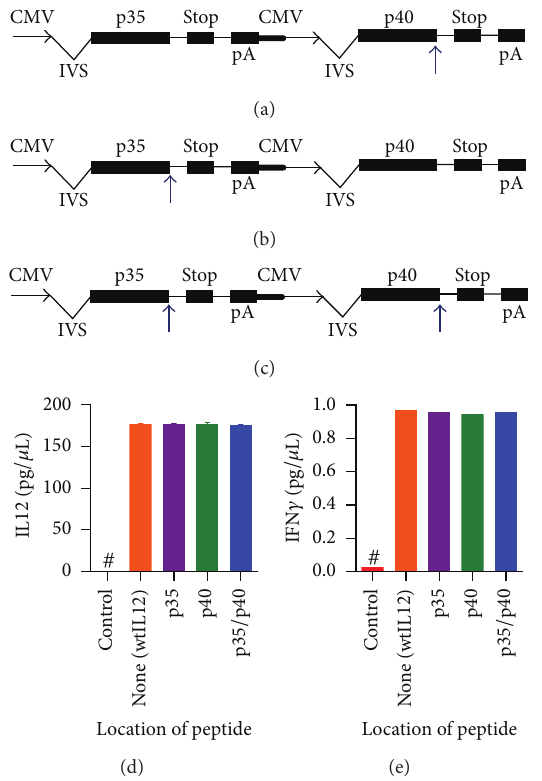
Figure 1: Expression and activity of IL12 is not affected by insertion of tumor-targeting sequence in either subunit. Multiple VNTANST- IL12 plasmids were created with the VNTANST sequence inserted directly prior to the stop codon in the p40 subunit (a), p35 sub- unit (b), or both subunits (c). The blue arrows represent the VNTANST-coding sequence insertion site in the plasmid DNA. CMV: cytomegalovirus promoter; IVS: intron; pA: bovine growth hormone polyadenylation signal; STOP: stop codon. (d) Transfec- tion of these plasmids and wild-type IL12 and a control plasmid into cellsresultedinequivalentamountsofexpressedIL12inthemedium oftransfectedcells.(e)ThepeptideIL12productsinducedequivalent levels of IFN 𝛾 from harvested murine splenocytes. # represents 𝑃 < 0.05 compared to all other